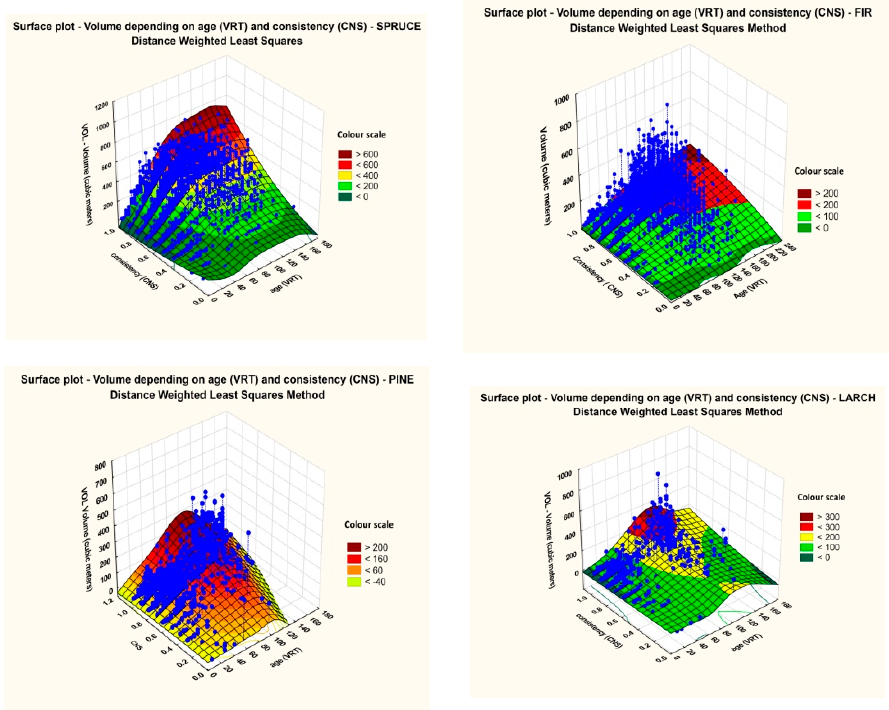
Figure 17. Three-dimensional VOL diagram based on VRT and CNS.